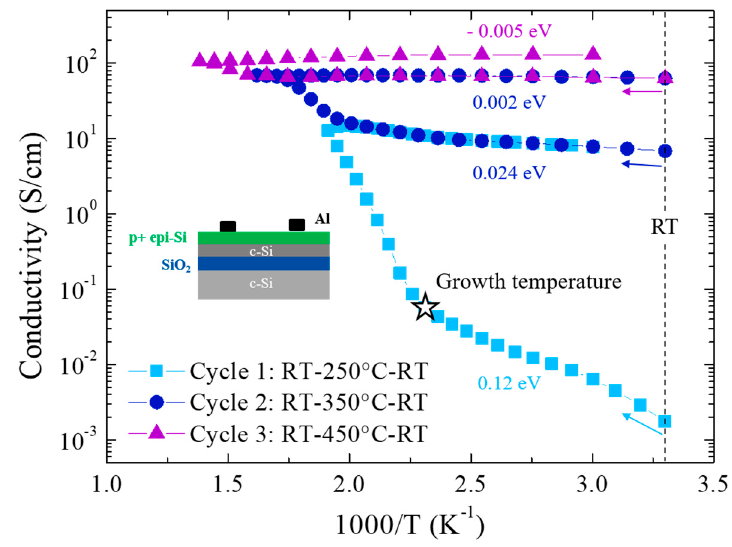
Figure 3. Three cycles of dark conductivity measurements as function of the temperature were performed on SOI samples. The star corresponds to the growth temperature (180 °C).